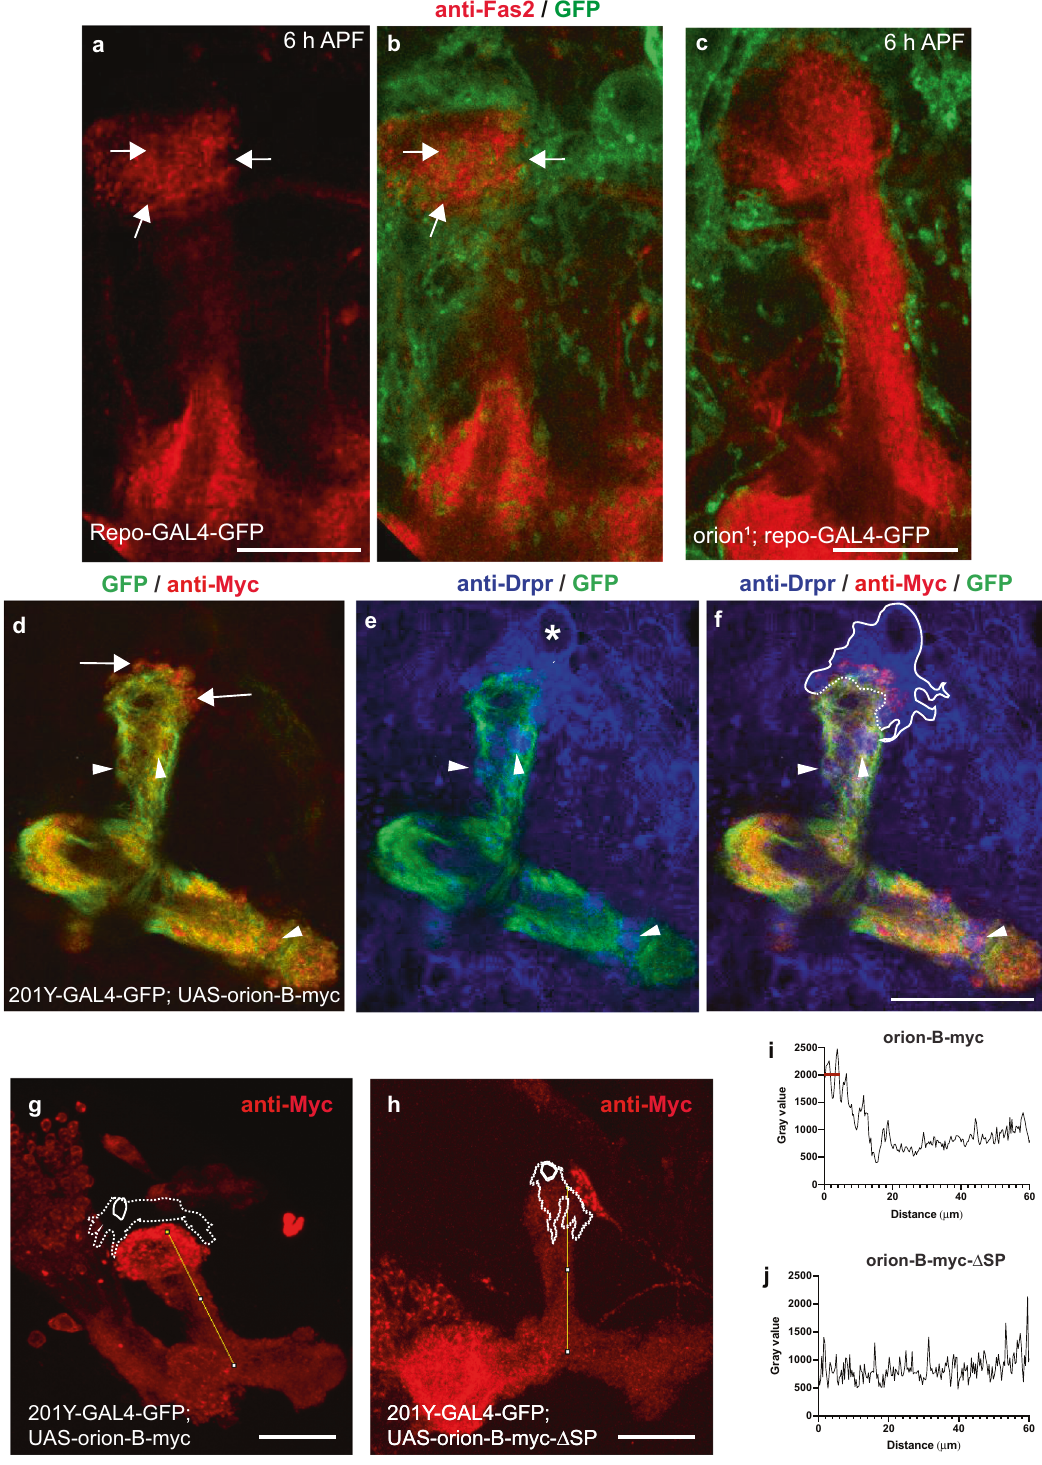
were aligned using the AlignX plug-in in the VectorNTi software package (Invi- trogen) without permitting the introduction of spaces or deletions. GAG binding site research . Identi fi cation of GAG binding sites in proteins, in the absence of structural data, is complicated by the diversity of both GAG structure and GAG binding proteins. Previous work based on heparin-binding protein sequence comparisons led to the proposition of two GAG binding consensus sequences, the XBBXBX and XBBBXXBX motifs (where B and X stand for basic and neutral/hydrophobic amino acids, respectively). A number of closely related basic clusters, including XBBXBXBX, were next experimentally identi fi ed 42 . Visual